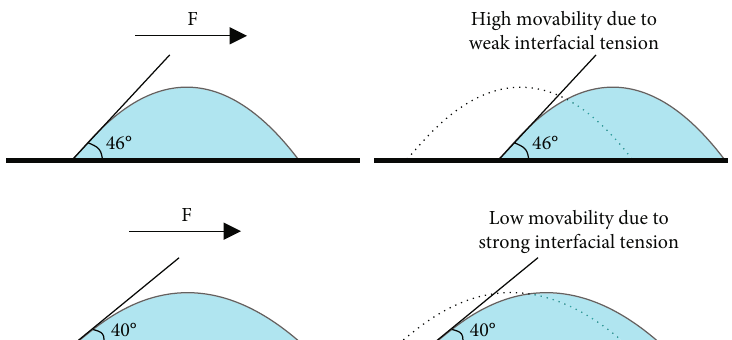
Figure 9: Schematic diagram of models for the droplet used to interpret the fl uid